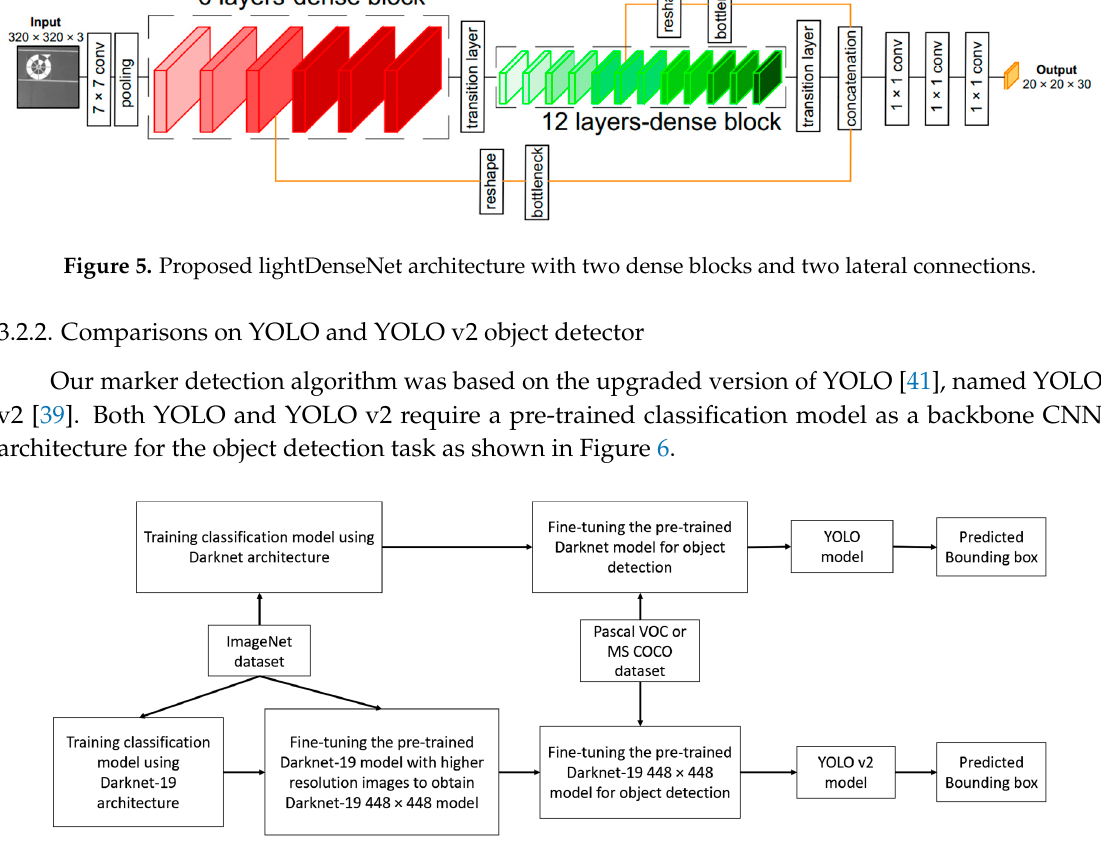
Figure 6 . Overall flowchart of the training of YOLO and YOLO v2 for object detection